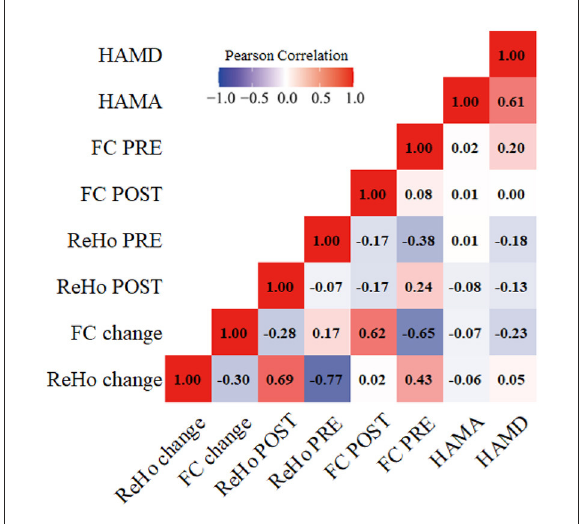
FIGURE5 Correlations between the clinical scales’ scores and the fMRI values. HAMD, Hamilton rating scale for depression; HAMA, Hamilton anxiety rating scale. ReHo, Regional homogeneity; FC, Functional connectivity; ReHo PRE/FC PRE, before taVNS treatment; ReHo POST/FC POST, after taVNS treatment; ReHo change/FC change, the difference in value before and after treatment.